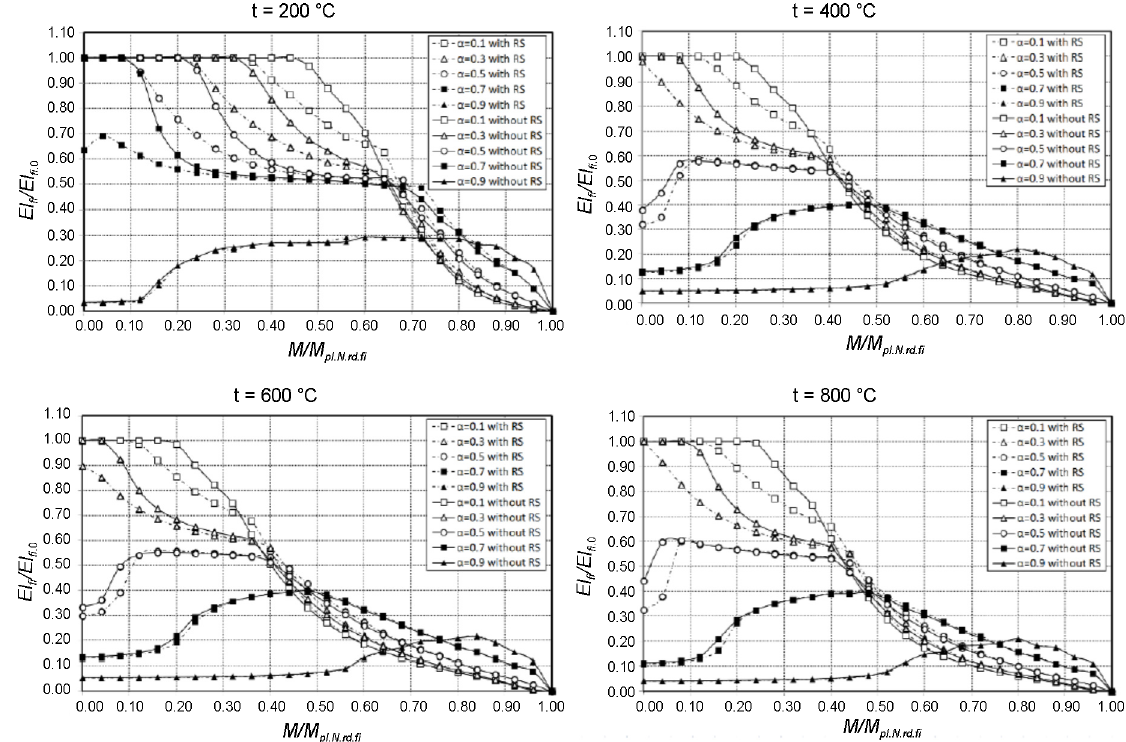
Fig. 2. Influence of RS on the stiffness reduction factor ( EI fi /EI fi. 0 ) as a function of the bending capacity utilization factor ( M/M pl.N.Rd.fi ) for rolled I-section (HEA500) strong